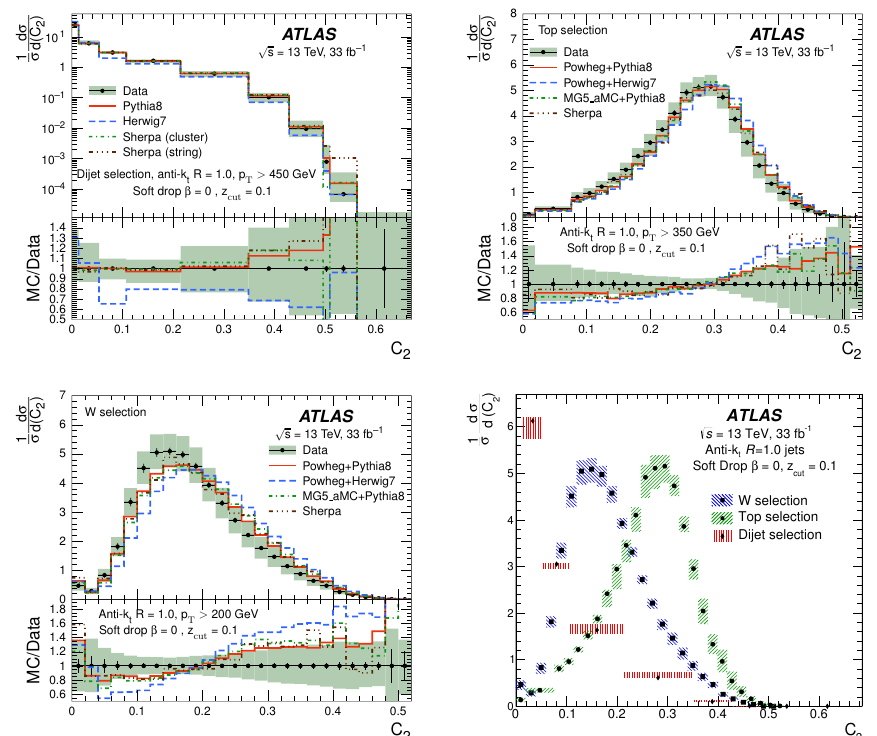
Figure 5 . The distributions of C 2 compared with different MC predictions for soft-dropped large- radius jets from dijet (top left), top (top right), and W (bottom left) selections. For the dijet selection, Sherpa is tested with two different hadronisation models. Data are compared between the soft-dropped large-radius jets for the three selections mentioned above (bottom right). The shaded bands represent the total uncertainty, while the error bars show the statistical uncertainty, except in the bottom right plot, where the shaded areas represent the total